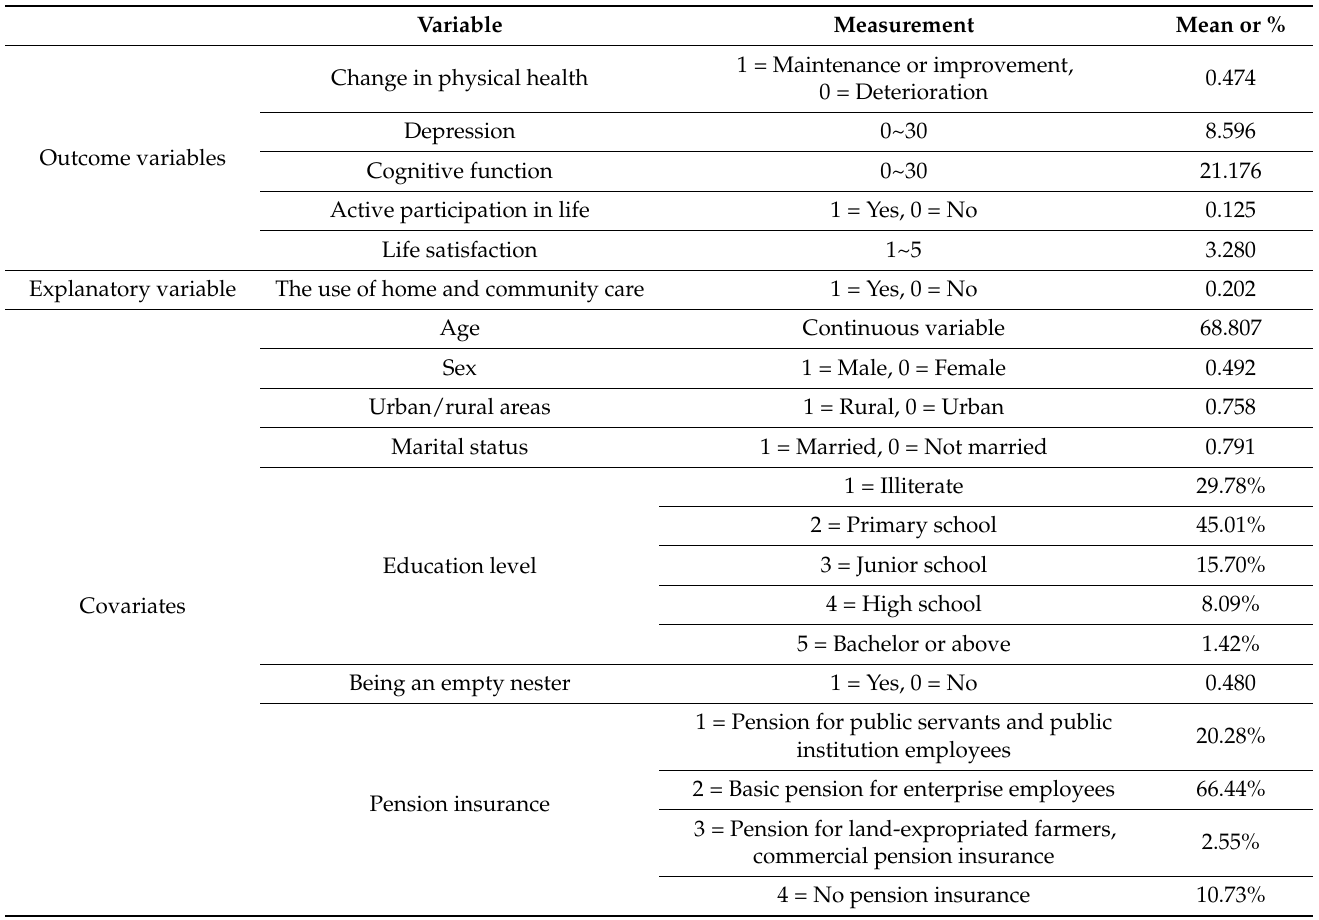
Table 1. Variables and their